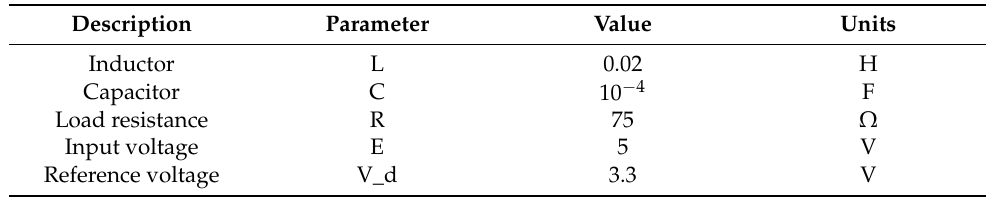
Table 1. Parameter